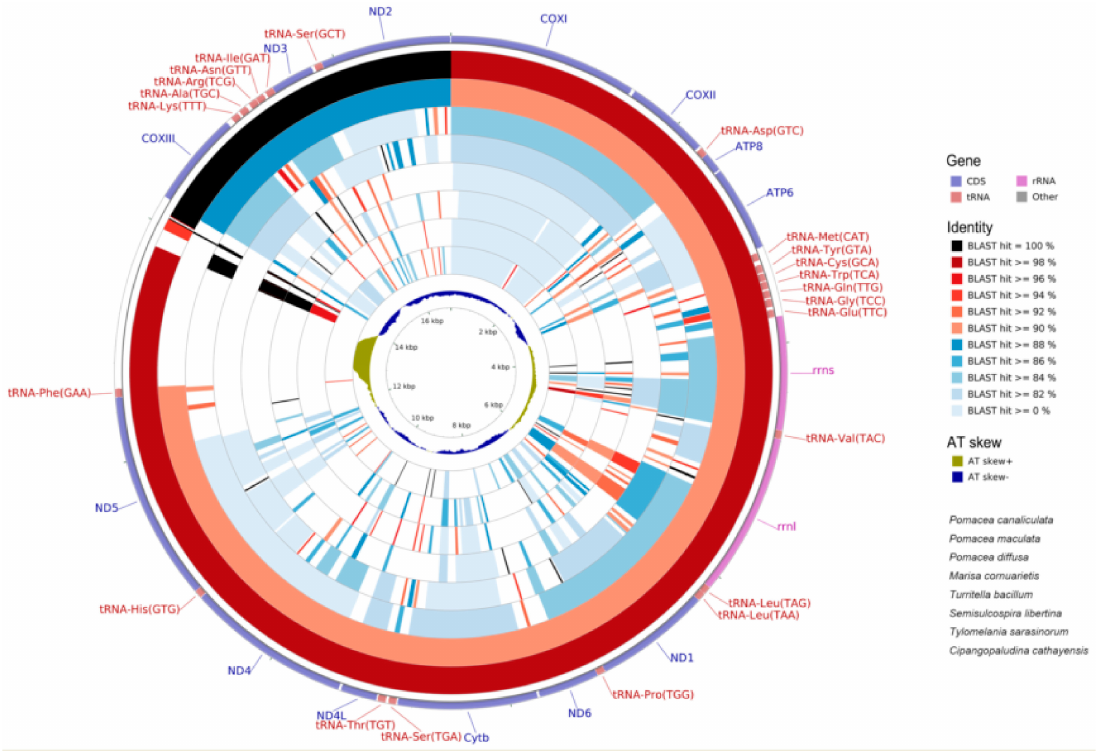
Figure 6. Graphical map of the BLAST results showing nucleotide identity between the complete mitochondrial genomes of P. canaliculata and species from the orders Sorbeoconcha and Architaenioglossa. BLAST results are presented in order with the sequence most similar to the reference ( P. canaliculata ) placed closer to the outer edge of the map. The gene regions, Blast identities and AT skew are depicted from outside to inside on the circle. The species from outside to inside are, respectively, P. canaliculata (KU052865), P. maculata (KY008699), P. diffusa (KY008698), M. cornuarietis (NC_025334), T. bacillum (NC_029717), S. libertine (NC_023364), T. sarasinorum (NC_030263) and C. cathayensis